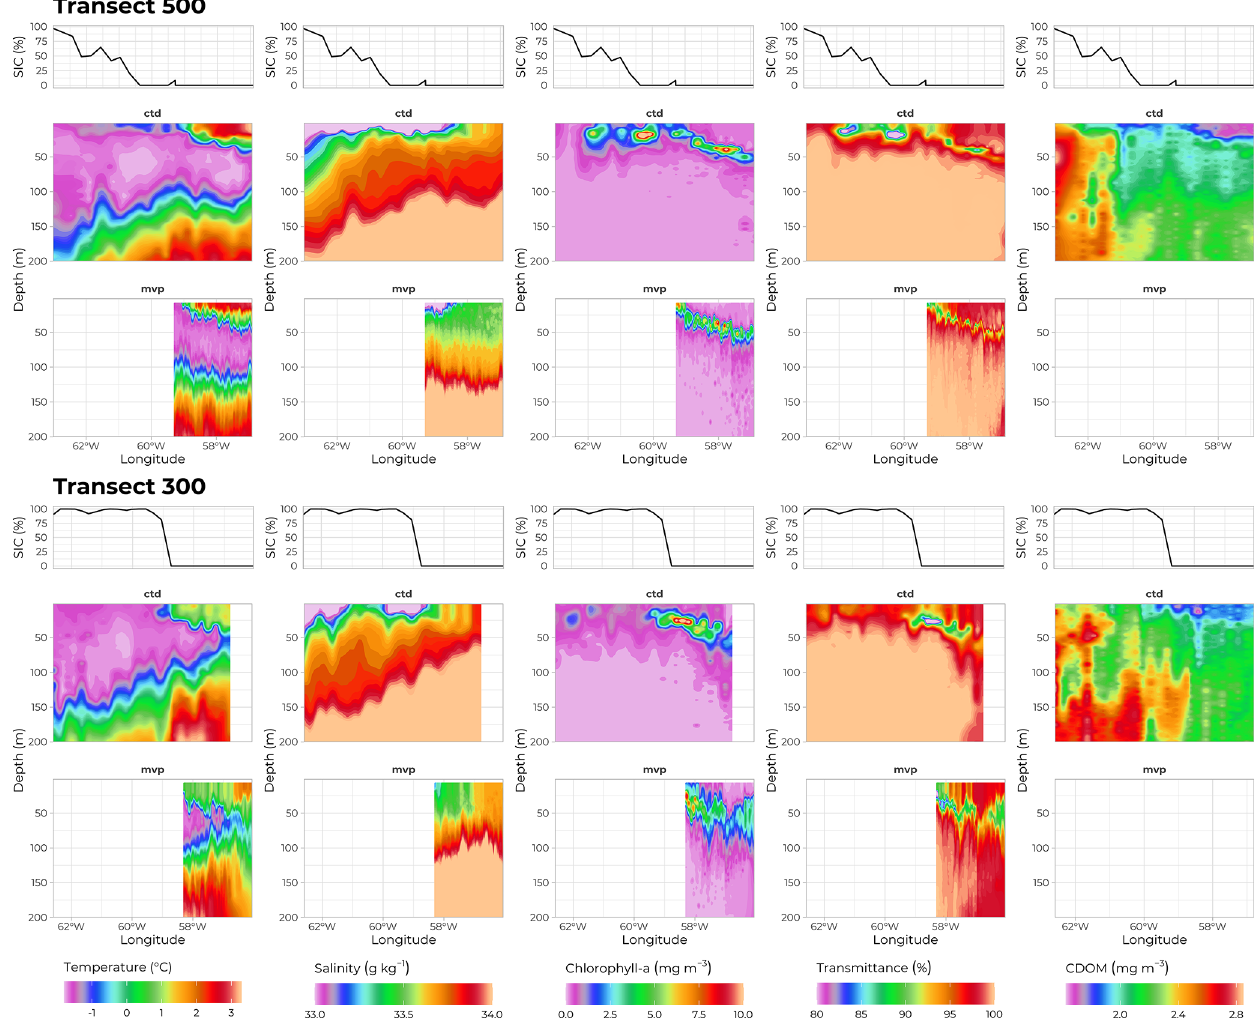
Figure 8. Physical properties of seawater along transects 500 (70 ◦ N) and 300 (69 ◦ N). Middle and bottom panels show data recorded by sensors deployed on the rosette and on the MVP, respectively. From left to right: temperature ( ◦ C), salinity (gkg − 1 ), chlorophyll a concentration (mgm − 3 ), transmittance (%), and CDOM concentration (mgm − 3 ) as a function of depth (m, y axis) and longitude ( ◦ W, x axis). Topmost panels show ice coverage (%) at corresponding longitudes. Note that the MVP did not carry a CDOM